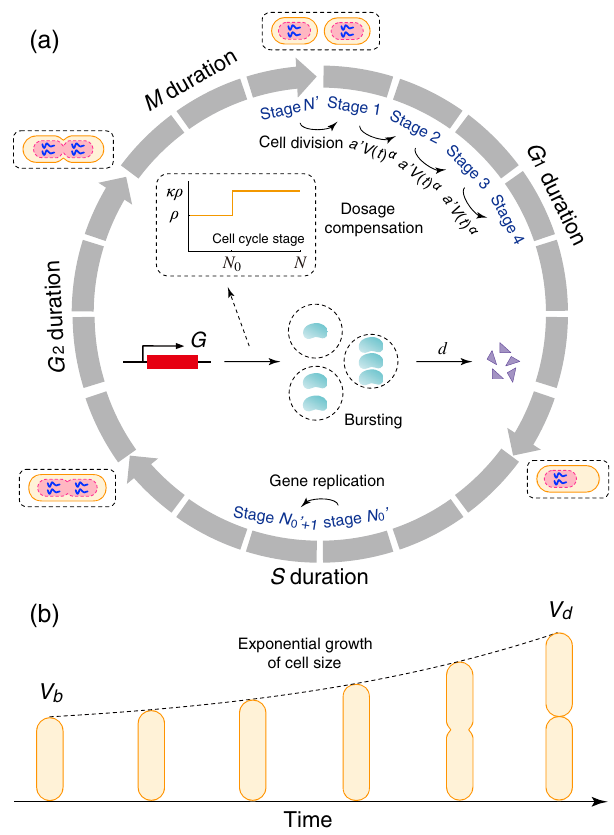
FIG. 5. The model including a cell-size description. (a) Sche- matic illustrating a detailed model of both gene expression and cell-size dynamics. Each cell can exist in N 0 effective cell cycle stages. The transition rate from one stage to the next at a particular time t is proportional to the α th power of the cell size V ð t Þ with α > 0 being the strength of cell-size control and a 0 > 0 being the proportionality constant. This guarantees that larger cells at birth divide faster than smaller ones to achieve size homeostasis. At stage N 0 , a mother cell divides into two daughters that are typically different in size via asymmetric cell division. (b) The cell grows exponentially between birth and division events with the growth rate being a generation-independent